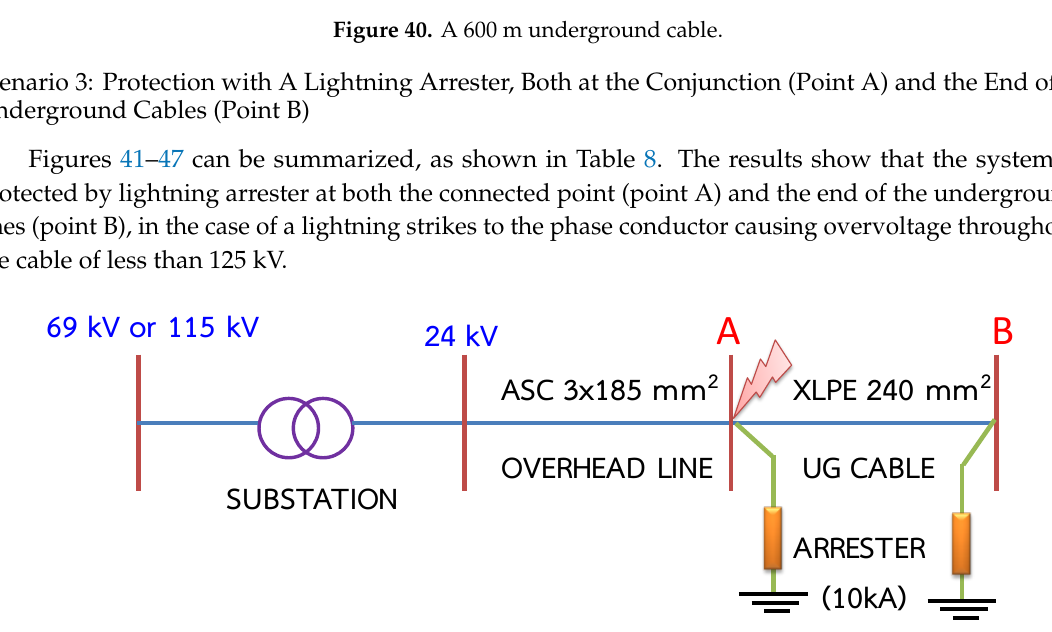
Figure 41. Protection with lightning arrester both at conjunction and the end of underground cables. Table 8. Maximum overvoltage (kV) at point A and B, where the current of the lightning strike to point A is 40 kA.